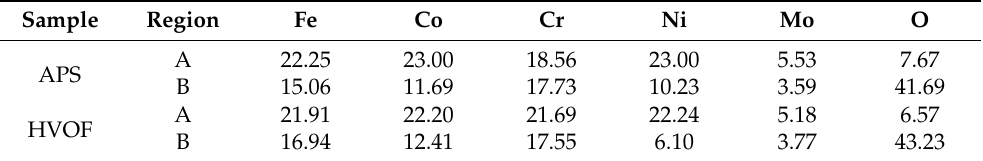
Figure 3. Cross-sectional scanning electron microscope (SEM) images of the air plasma spraying (APS) coating and the high-velocity oxy-fuel spraying (HVOF) coating at low and high magnifications. ( a ) APS coating at low magnification; ( b ) APS coating at high magnification; ( c ) HVOF coating at low magnification; ( d ) HVOF coating at high magnification. Table 3. Composition of the as-sprayed HEA coatings determined by energy dispersive spectrometer (EDS) analysis.